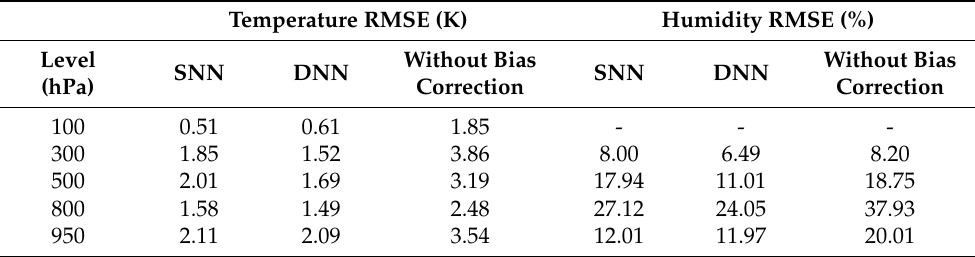
Figure 9. The retrieval RMSEs of the 1DVAR retrieval with respect to ERA-Interim. Table 4. Summary of the retrieval RMSE of the 1DVAR retrieval with respect to